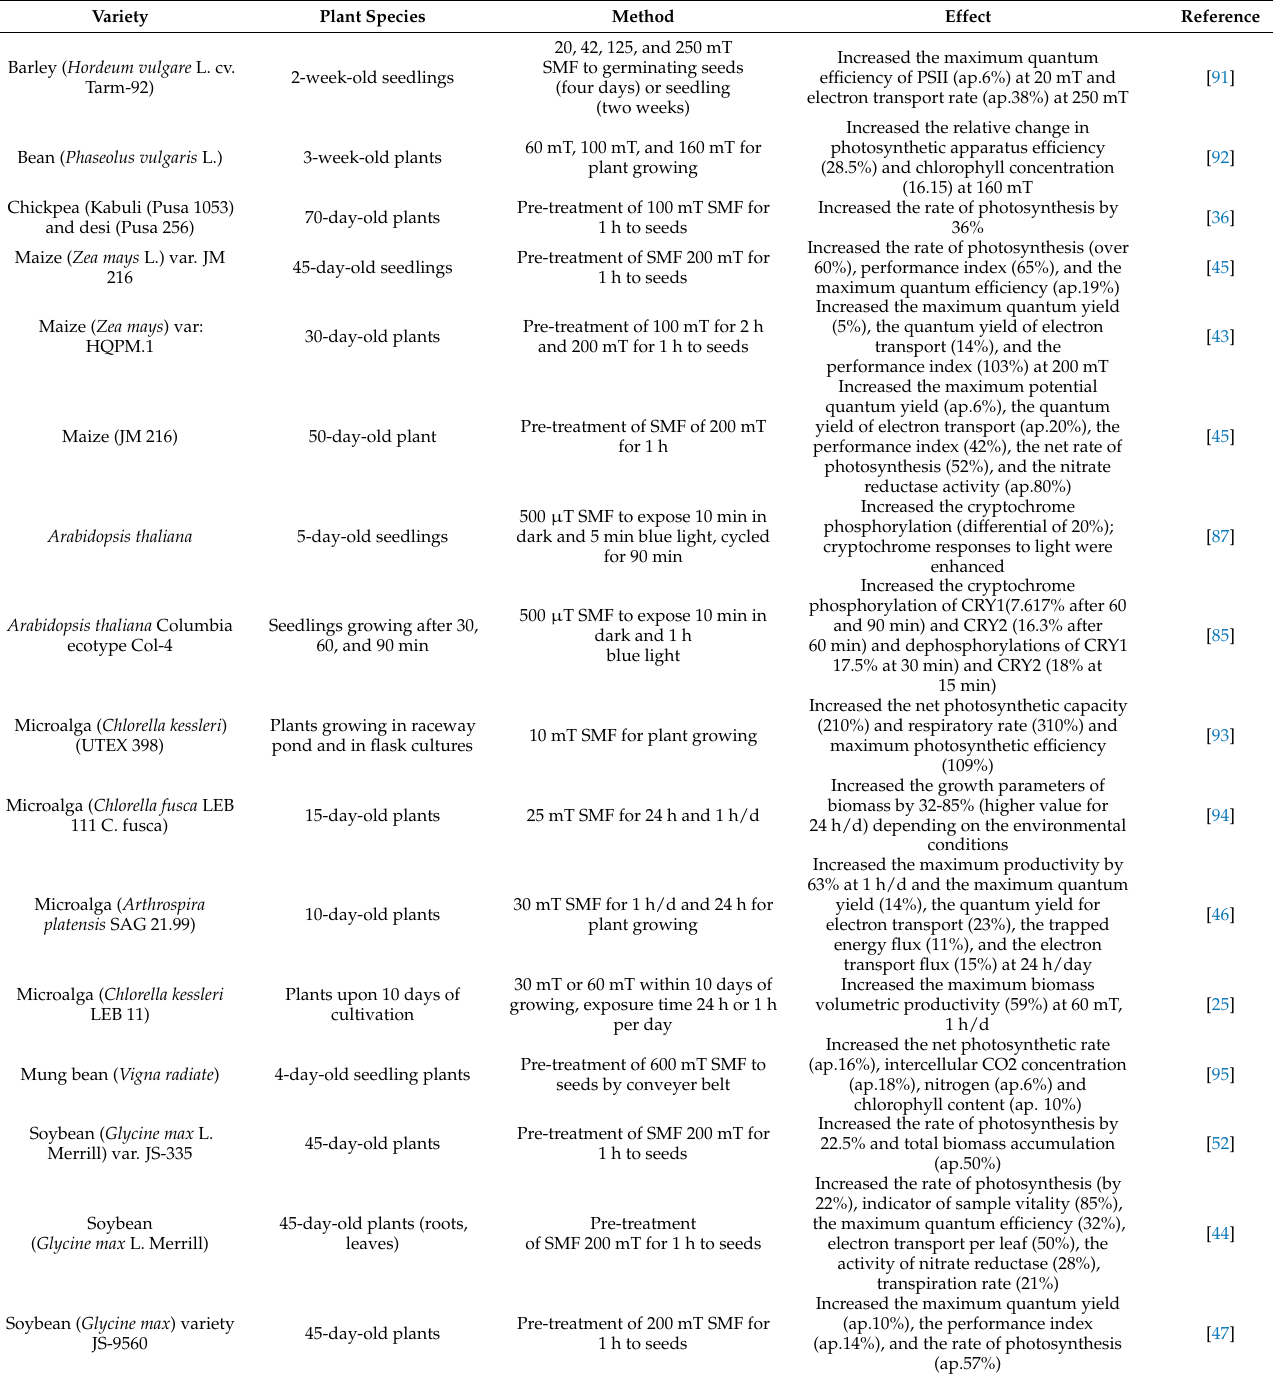
Table 1. Effects of MFs on photosynthesis and cryptochrome and biomass